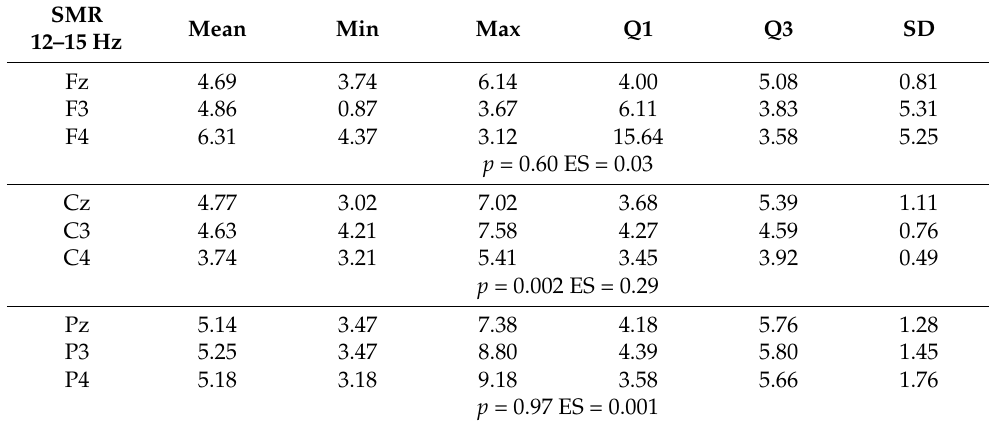
Table 5. Descriptive statistics of SMR waves from all channels ( µ